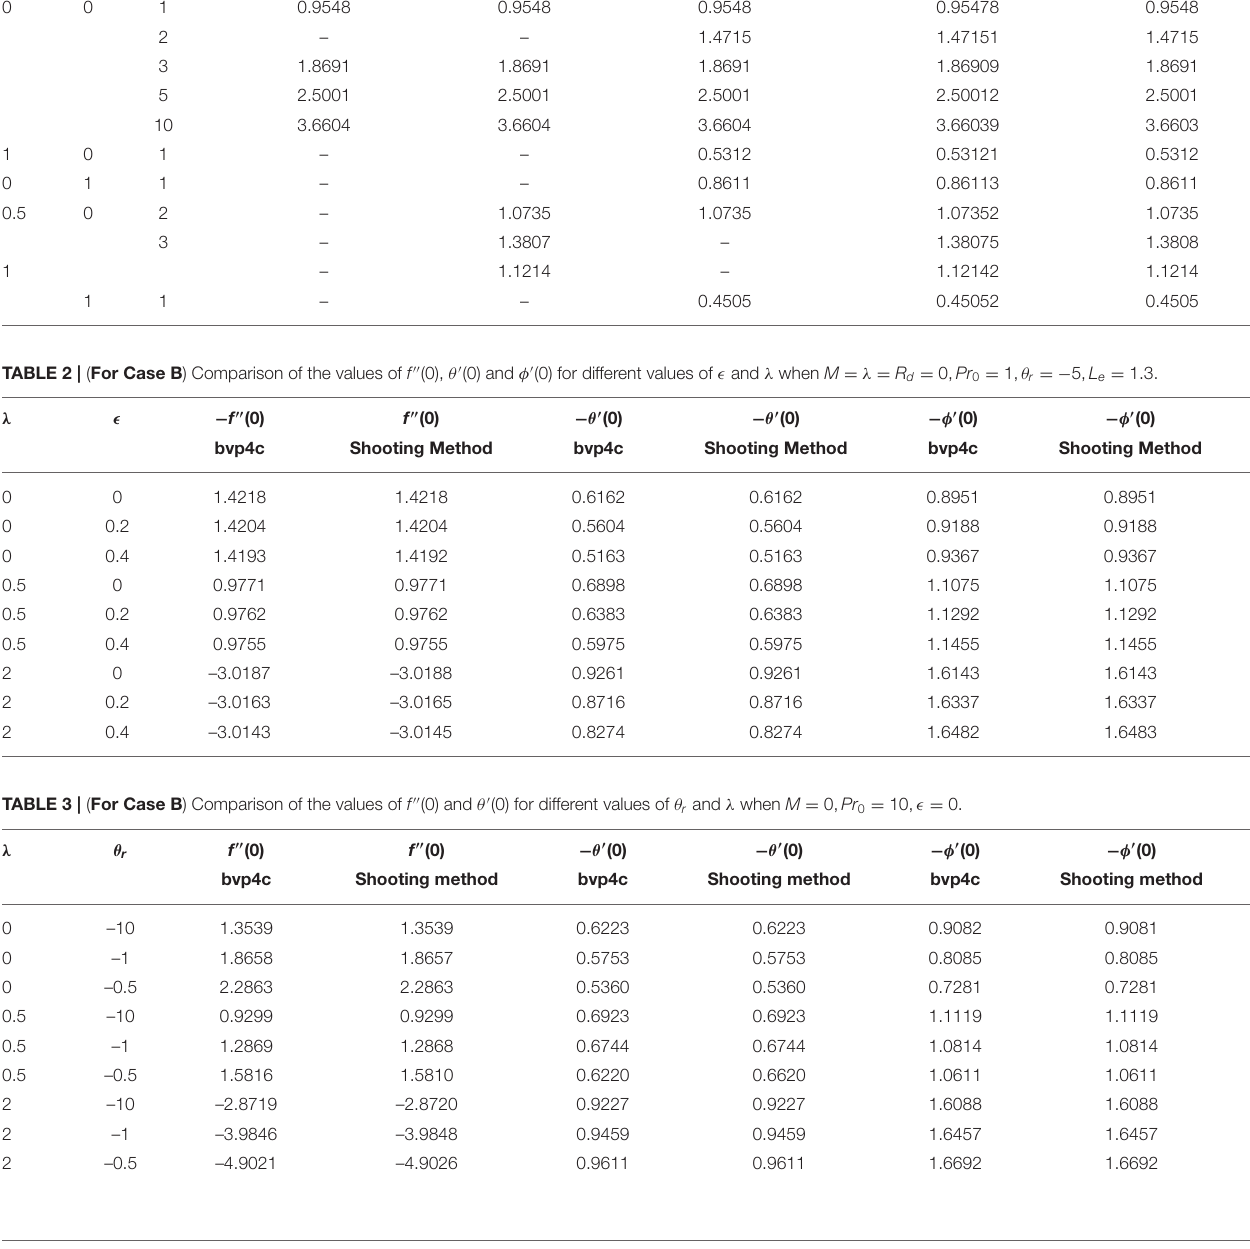
θ ′ (0) for different values of M , R d and Pr 0 , when λ −